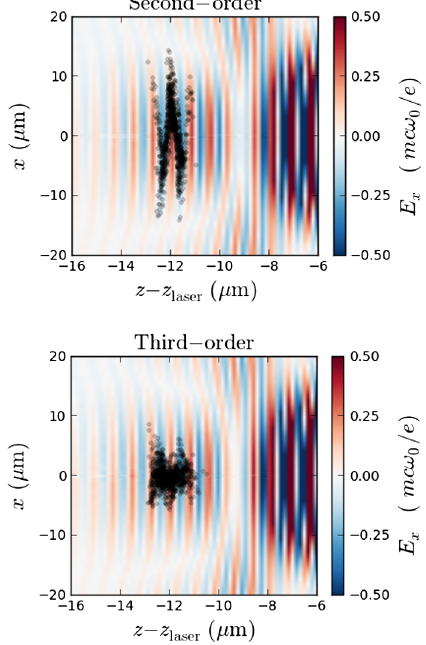
10. Snapshot of the simulation at z ¼ 550 μ m with the second-order accurate (top panel) and third-order accurate (bottom panel) methods. The electric field of the laser is virtually unchanged with the third-order method, but the electrons (black dots) experience a weaker